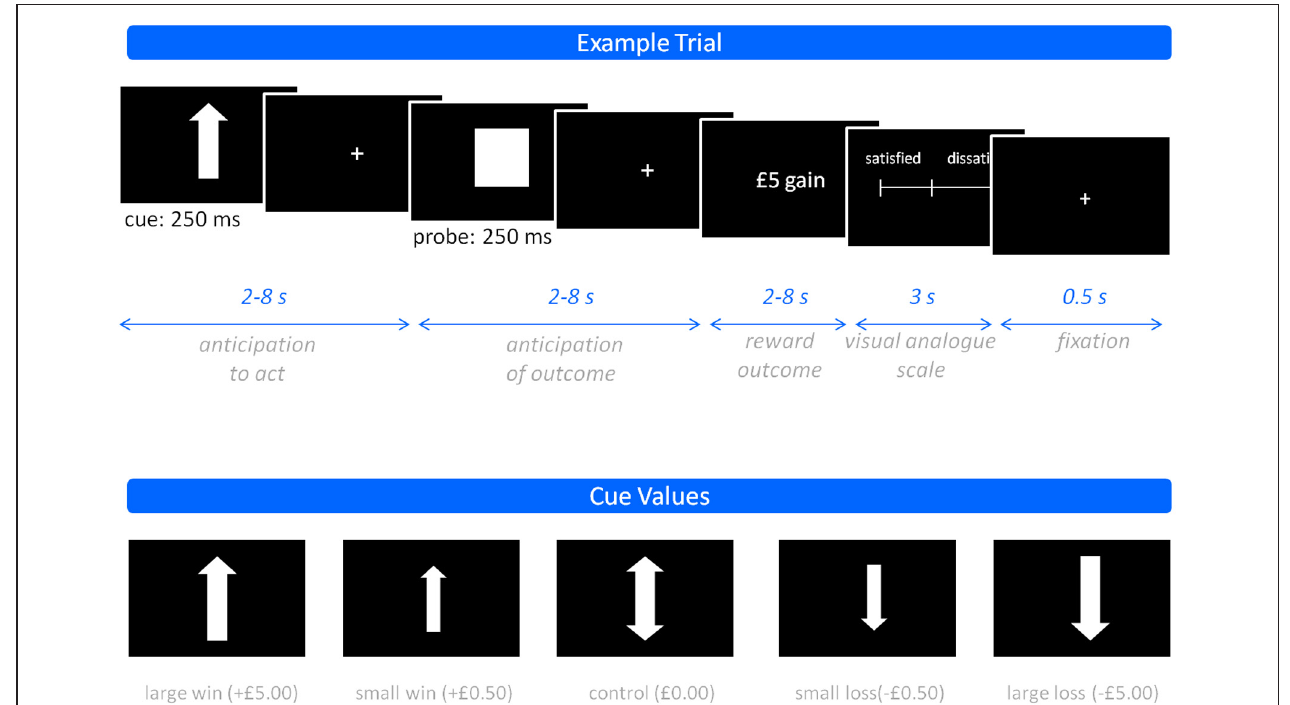
FIGURE 1 | The monetary incentive delay task. Showing an example trial (top) and the various cue values used (bottom).